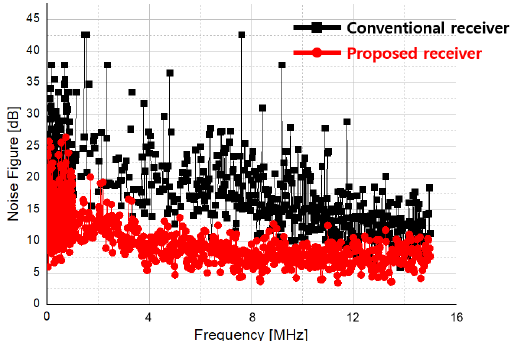
Figure 40. Noise figure result of conventional and proposed